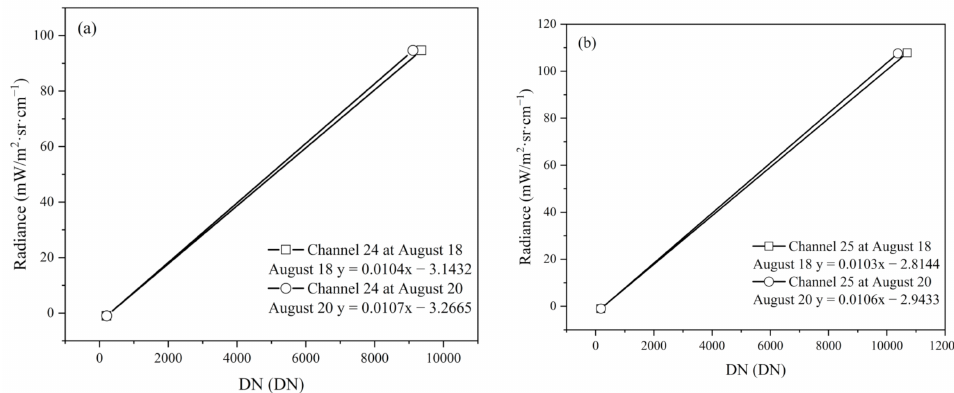
Figure 7. The calibration coefficients for the FY − 3D MERSI-II channel 24 and channel 25 derived from the calibration campaign, ( a ) Channel 24, and ( b ) Channel 25.